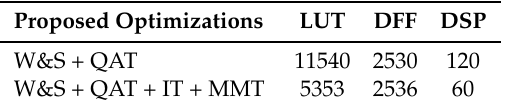
Table 2. FPGA resource utilization w.r.t. proposed optimizations.